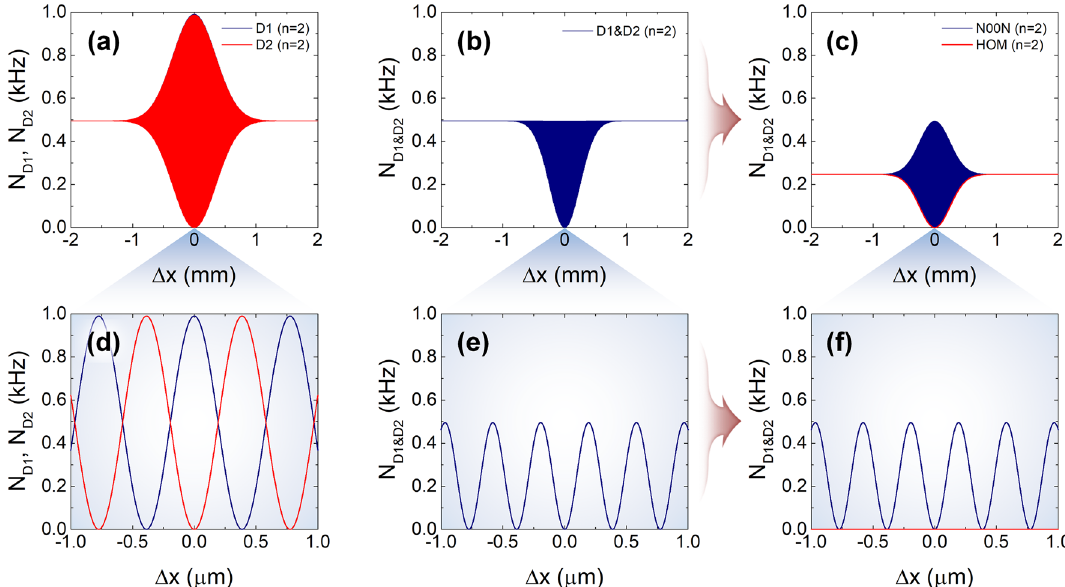
Figure 3. One- and two-photon interference fringes with weak coherent light with detection probability of two-photon component P ( 2 ) for mean photon number at the two single-photon detectors D1 and D2. ( b ) Two-photon coincidence fringe composed of the fringes caused by the two two-photon states Interference fringes for (cid:31) x